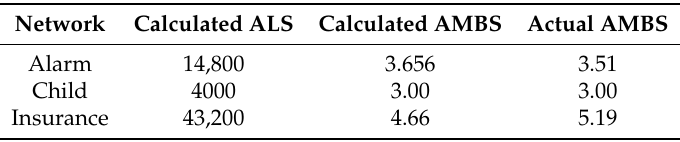
Table 3. ALS study